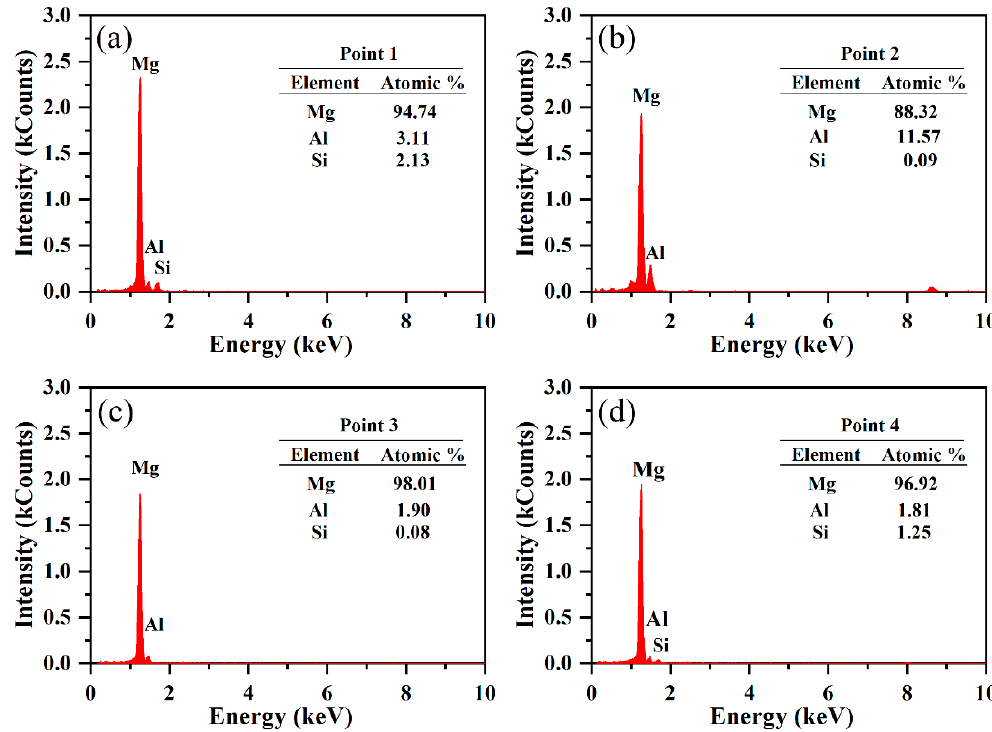
Figure 10. ( a – d ) EDS analysis at point 1, 2, 3, 4 in Figure 9b.